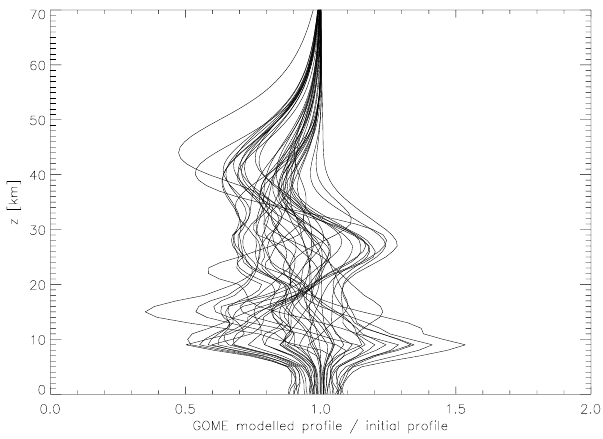
Fig. 7. Profiles of the ratio between the GOME profile calculated with FURM and the respective a priori profile used in the calcula- tion for all cases